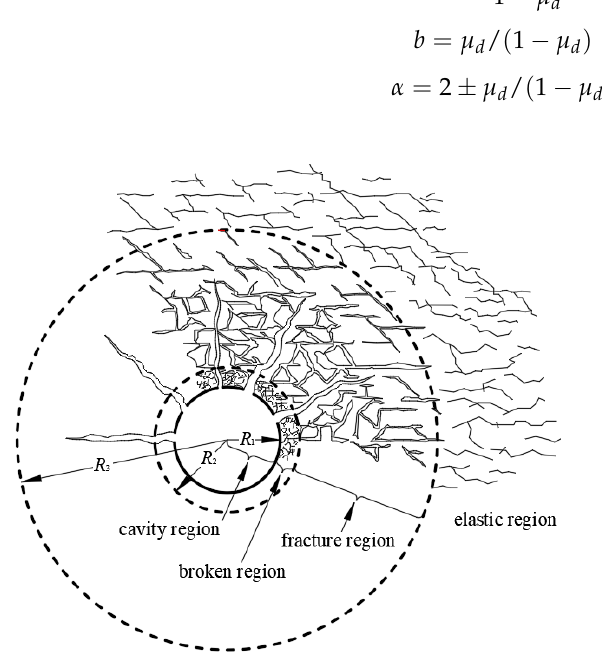
Figure 9. Drilling and blasting diagram.